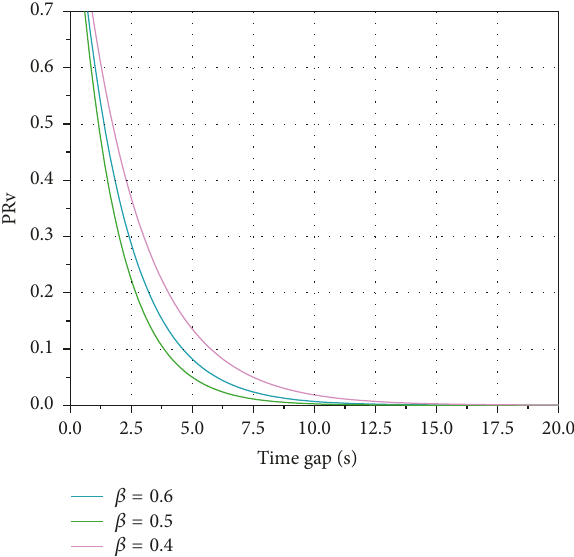
Figure 3: The relationship between perceived risk (PRv) and Δ𝑇 .